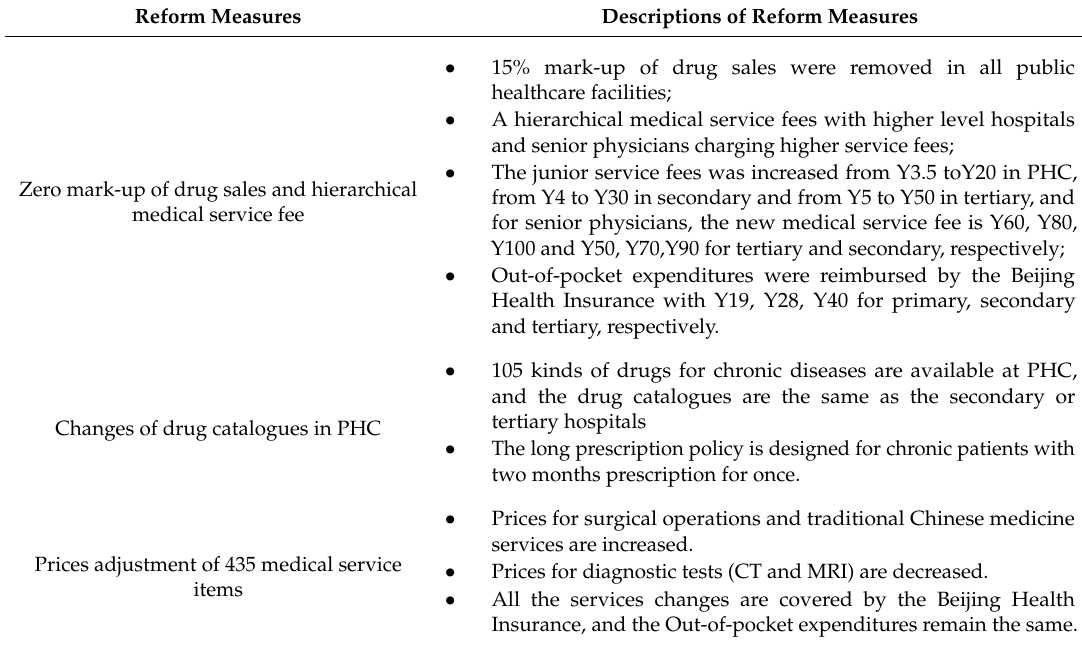
Table 1. The details of the main strategies for the Beijing Reform in April